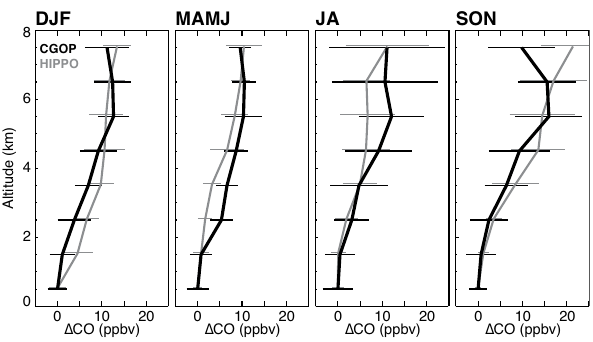
Figure 4. Median observed CO vertical profiles near Tasmania from the Cape Grim Overflight Program (CGOP; 1991–2000; black) and over the SH mid-latitude Pacific from the HIAPER Pole-to-Pole Observations (HIPPO; 2009–2011; gray). Profiles are shown as (cid:49) CO, the deviation (in ppbv) from the observed value in surface air in each season. For HIPPO, the JA season also includes two flights from early September. Thin horizontal lines show the observed me- dian absolute deviations across all years of